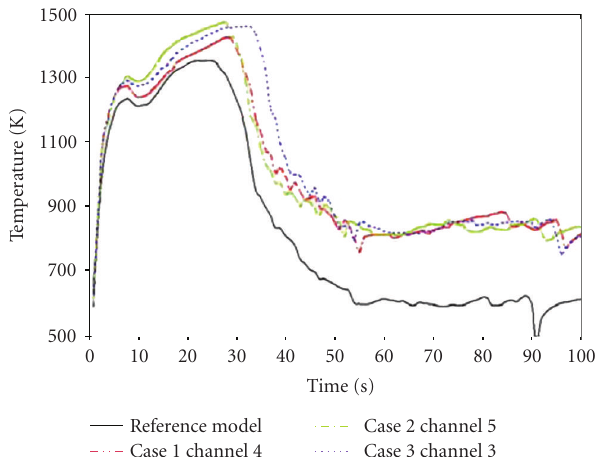
Figure 15: Maximum fuel bundle cladding temperatures for a CANDU-6 Inlet manifold break analysis for di ff erent break locations.